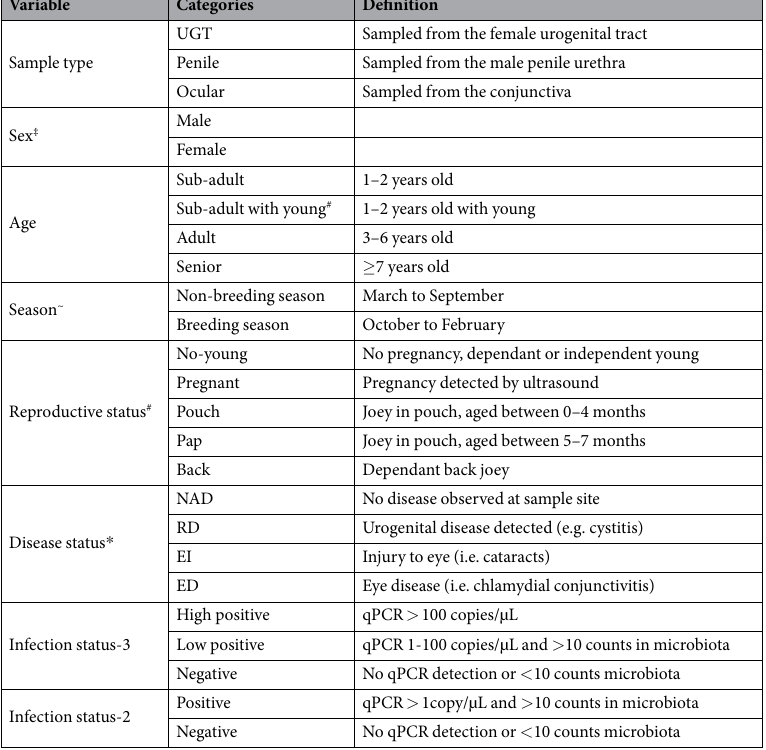
demonstrated OTUs significantly correspond for each variable tested (Table 2). When these variables were tested together, CCA identified infection status-3 and disease status to be the dominant explanatory variables for this dataset (Fig. 5a). The primary principal component demonstrated that high C . pecorum infection status associates with a different OTU composition compared to low and negative samples. The top 5 contributing OTUs were; Aerococcus OTU1, Aerococcus OTU31, Peptoniphilus OTU66, Propionibacteriaceae OTU0, and Campylobacter (Supplementary Table S2). It is in the secondary principal component that differences between low and nega- tive C. pecorum detections are observed. These variations interestingly co-correlated with disease status, with low C . pecorum detection being correlated with reproductive disease (RD) and negative C . pecorum infection status with no associated disease (NAD). The top 5 contributing OTUs associated with low C . pecorum were ; Lachnospiraceae OTU11, Aerococcus OTU19, Streptococcus , Enterobacteriaceae OTU868 and Enterobacteriaceae OTU29 (Supplementary Table S2). CCA of the penile microbiota identified age and disease status as the dominant explanatory variables, with infection status a co-correlated variable (M14) (Fig. 5b). The primary principal component is associated with age, with sub-adults being different in OTU composition to adult and senior animals (Fig. 5b), which are closely associated in both the primary and secondary principal components. The secondary principal compo- nent is dominated by disease status, with positive infection status co-correlating with RD, adult age, and sen- ior age, and negative infection status correlating with NAD and sub-adult age. The dominant variable of the third principal component was infection status, with the OTUs that correlated with a positive infection status being, Aerococcus OTU67, Flavobacterium , Propionibacteriaceae OTU64, Porphyromonas , and Desulfarculaceae OTU170 (Supplementary Table S3). The study highlights a few organisms of interest. However, the differences observed do not represent patterns of presence or absence but rather mean abundance of an OTU within the biological variable cohorts. This sug- gests that there is not a direct correlation between C . pecorum and presence or absence of a single member of the microbiota, but rather a correlation in the overall microbiota composition. This is not an unexpected result for a urogenital chlamydial infection. In the case of C . trachomatis infections of the human vaginal tract, the presence of indole-producing organisms support chlamydial replication by preventing interferon- γ mediated starvation of tryptophan 4 and differences in the dominant Lactobacillus influence infectivity by altering the environment and glucose metabolism 8 . In both of these examples, it is not the organism per se that is important, but rather the metabolic resources and environmental influence of the organism, or multiple organisms, that affect the infective potential of C . trachomatis .